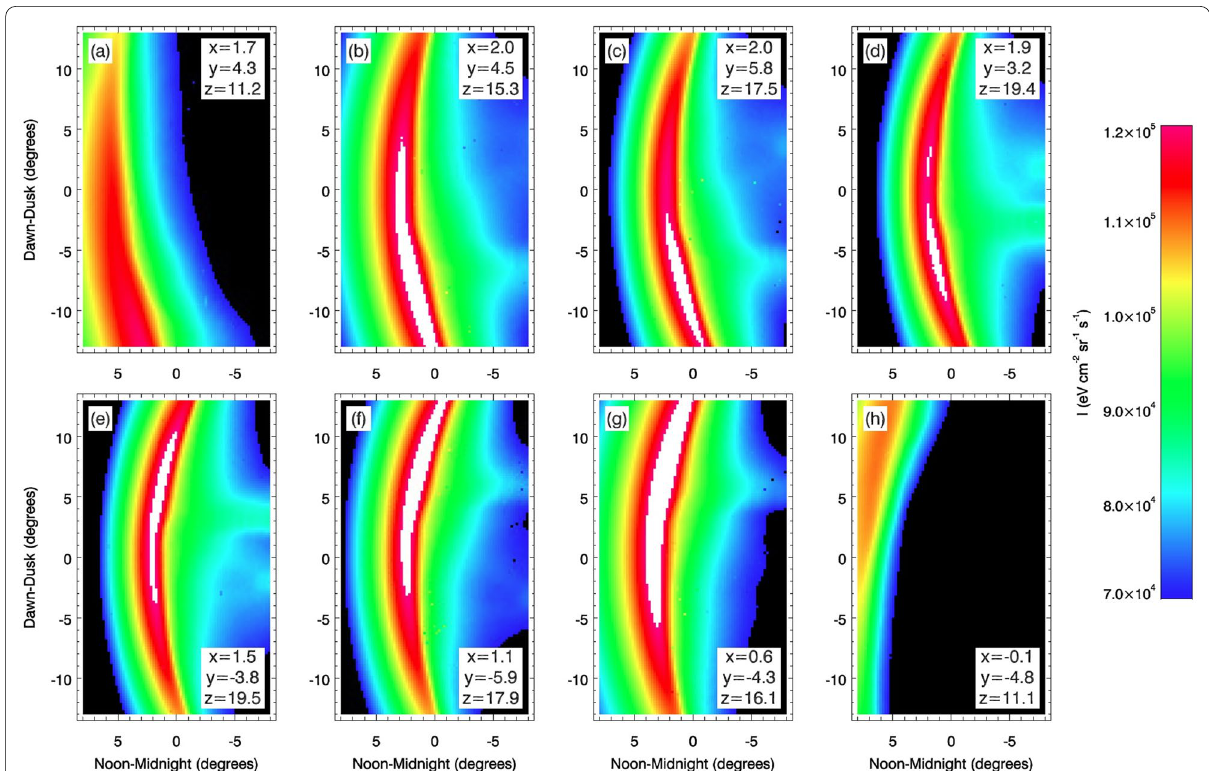
Fig. 8 Simulated soft X-ray images. Simulated soft X-ray images of the emissions from MHD results for a nominal geometric factor and integration time for the apogee pass of SMILE (Figure adapted from Jorgensen et al.